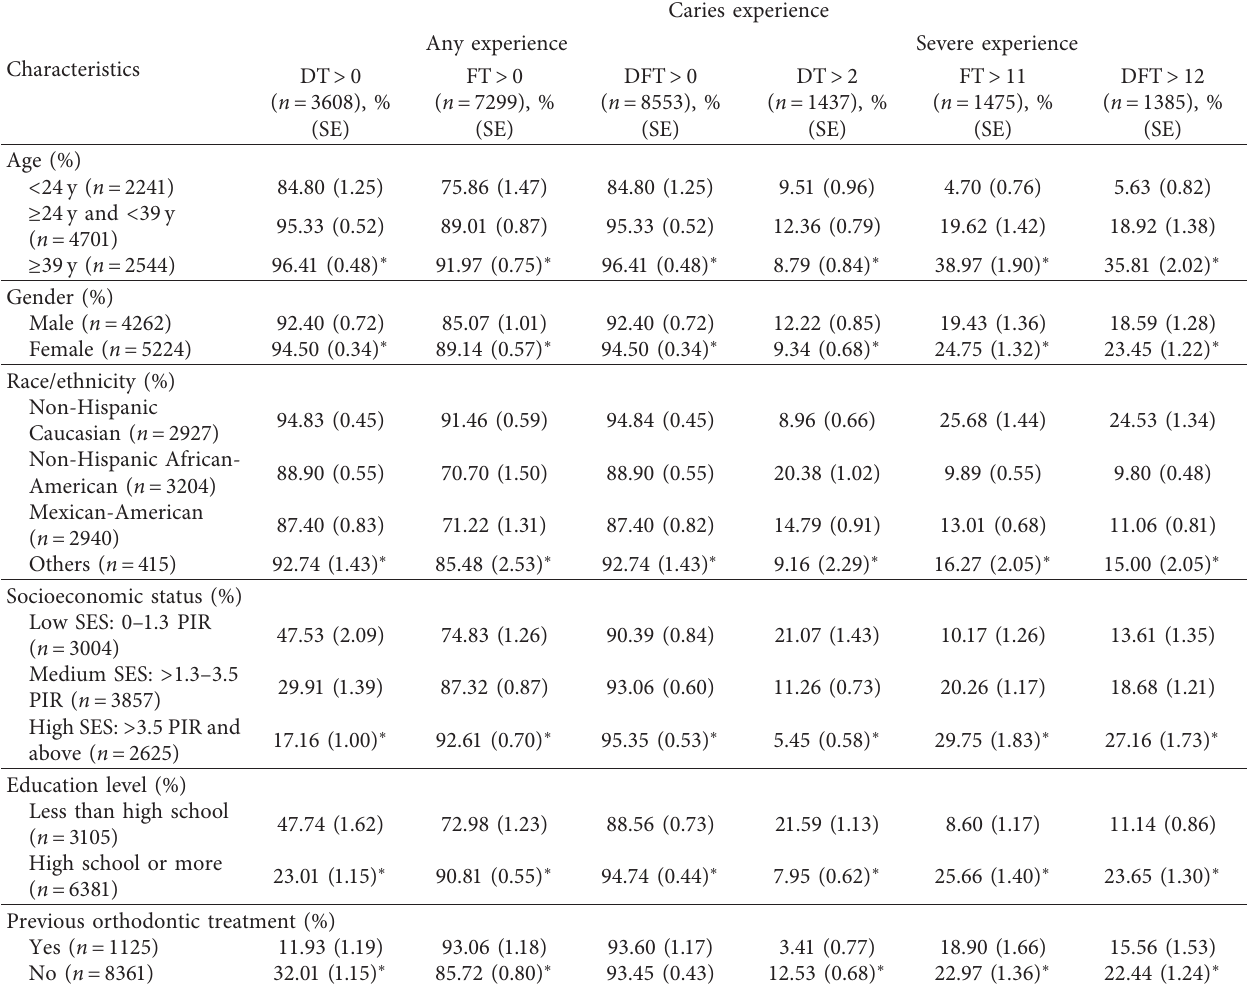
Table 3: Characteristics of study participants with caries experience ( n �